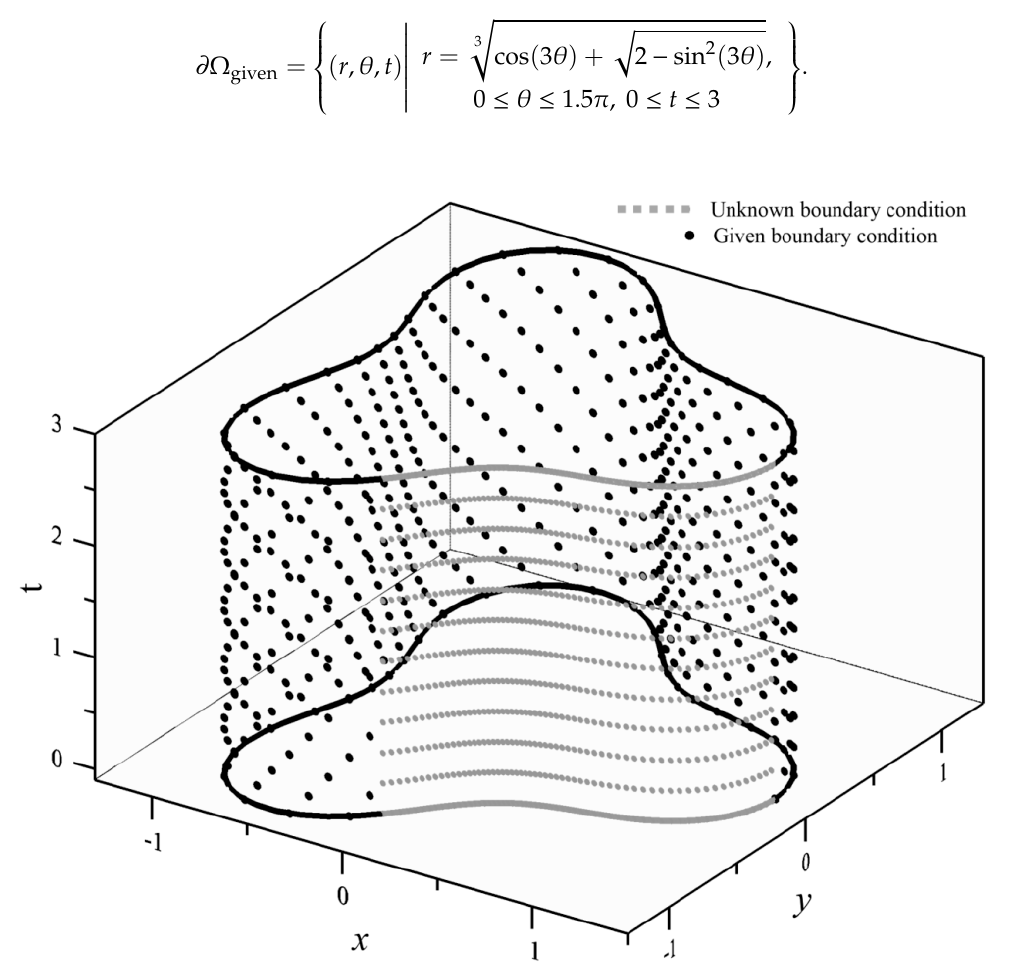
Figure 3. The space–time collocation scheme of this study.